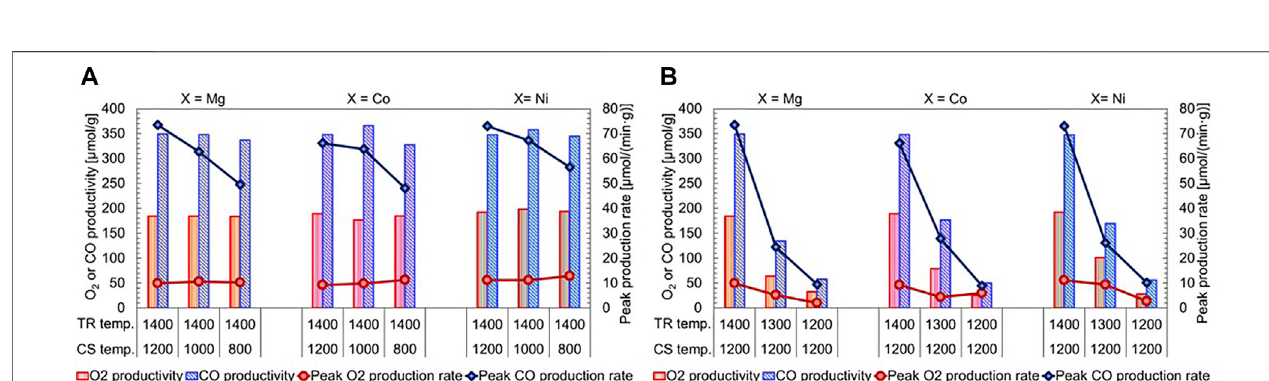
FIGURE5| COproductionpro fi lesofsamplesbelongingto (A) groupA(Cu,Cr,andCe-substitutedLSMs), (B) groupB(Fe,Al,andGa-substitutedLSMs),and (C) group C (Co, Ni and Mg-substituted LSMs) during the TR step in the fi rst to fourth runs. The production pro fi les correspond to left Y-axis, while the temperature pro fi le corresponds to right Y-axis.